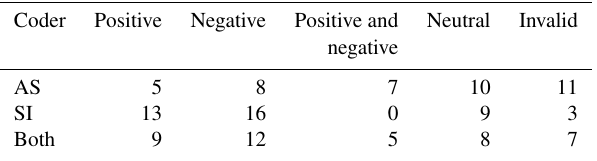
Table 1. Classification of the 41 poems according to their portrayal of the relationship between volcanoes and the societies and times represented by poets who wrote about them as either “positive”, “negative”, “positive and negative”, “neutral” or “invalid”. Here the rows represent who the coding was performed by (AS: Arianna Sol- dati; SI: Sam Illingworth; both: Arianna Soldati and Sam Illing-